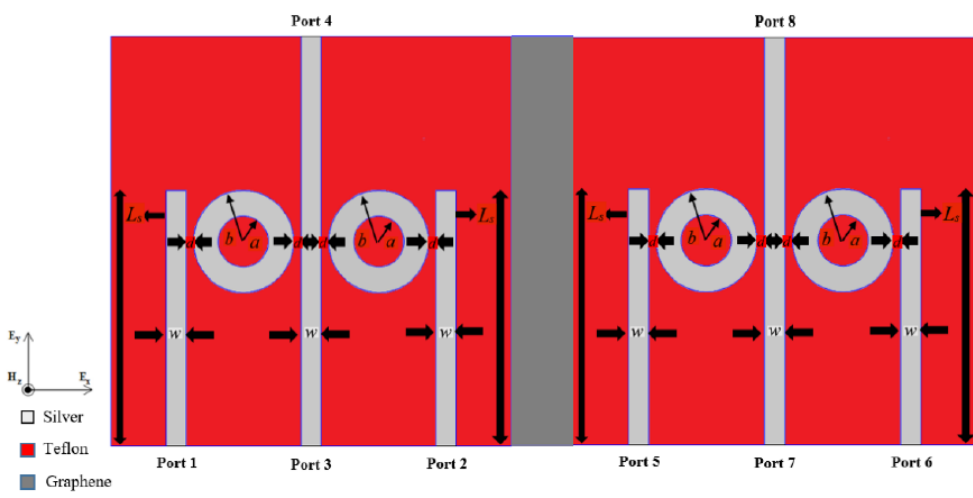
Figure 1. The proposed structure for the proposed plasmonic four combinational logic functions.